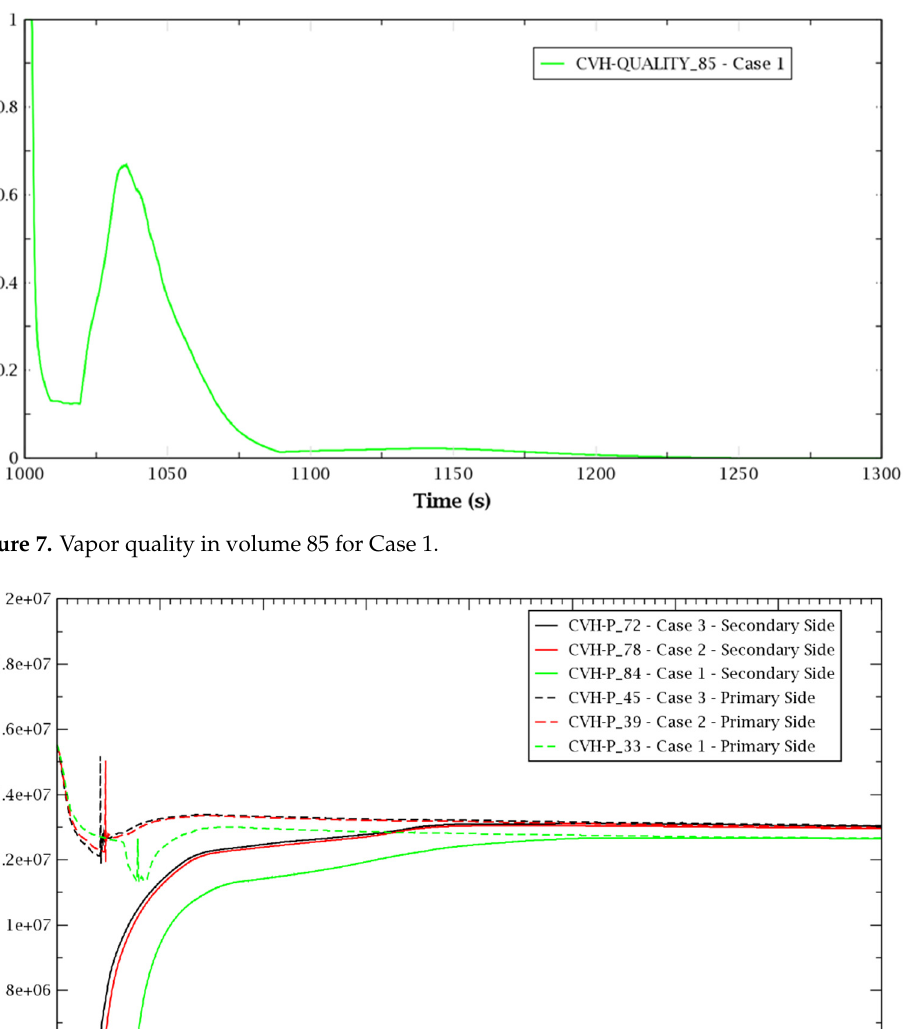
Figure 9. Pressure trend after the rupture: primary and secondary sides. 5.2. Temperature Evolution in the BB Figures 10–12 show the time evolution of the temperature at the inlets and outlets of the BB, for the whole transient up to 36 h. Because of the effect of the decay heat, the temperatures did not reach a steady state, but tended to increase. The faster temperature increase after 10 4 s was due to the onset of weak natural circulation in the loop, with the water flow even changing direction several times in Cases 2 and 3, as shown in Figure 13. However, the increase could be considered slow throughout the whole transient, and all temperatures remained well below acceptable values. As mentioned above, the difference between Case 1 and Cases 2 and 3 was due to a different height of the rupture in the primary side of OTSG for the three cases, with a jump of around 5 m between each case. The transient for Case 1 showed a different behavior from the very beginning, because, in this case, the primary discharged, through the rup- ture, into a region of the secondary which was filled with superheated vapor and not liq- uid water, as in Cases 2 and 3. This early difference consequently led to a radically differ- ent transient of the pressure and general behavior of the loop, compared with the other two cases.